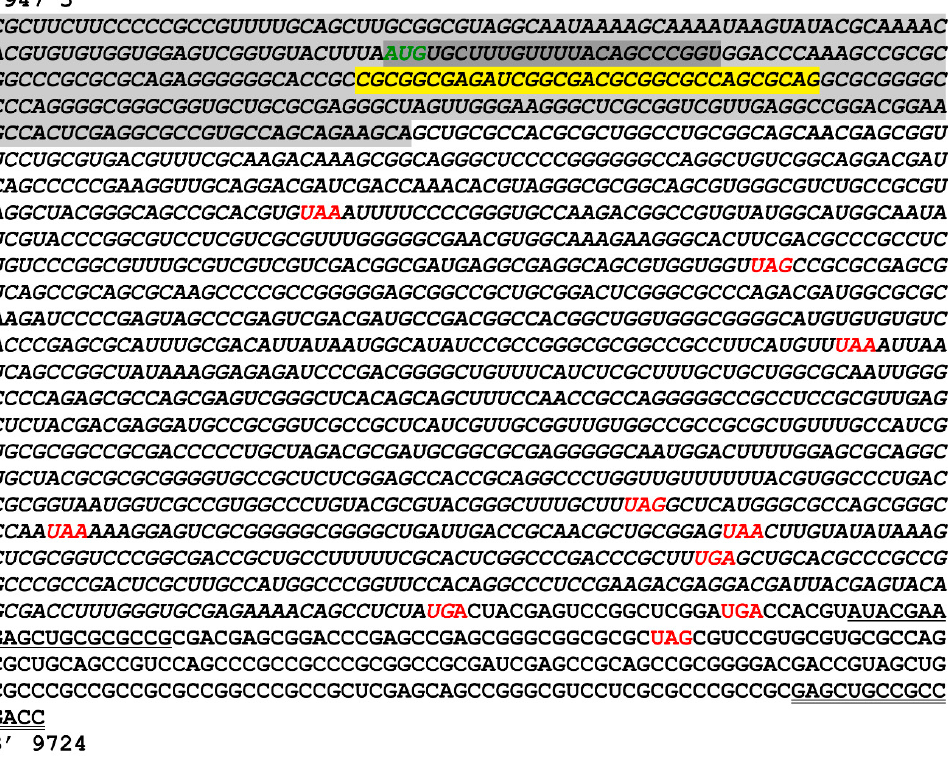
Figure 6. ORF-A Transcript Sequence. Sequence for ORF-A as determined by 5 ′ RACE and 3 ′ primer walking. The sequenced 5 ′ RACE product is shaded light gray and the darker gray shading indicates the location of the forward primer used for the 3 ′ walking strategy. Yellow highlighted text shows the sequence that encodes the experimental peptide found via MS/MS. Potential canonical start and stop codons are indicated in green and red, respectively. Italic text is the region of the transcript that has been confirmed by sequencing. Single and double underlined text show the binding site for primers 13 and 14, respectively.